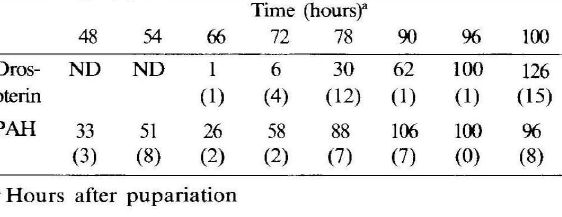
Table 2. Correlation between PAH concentration and dro sopterin/isodrosopterin content. ND = nondetected. Values are percentages of the ones obtained at adult emergence (96 hours). Values between brackets are standard